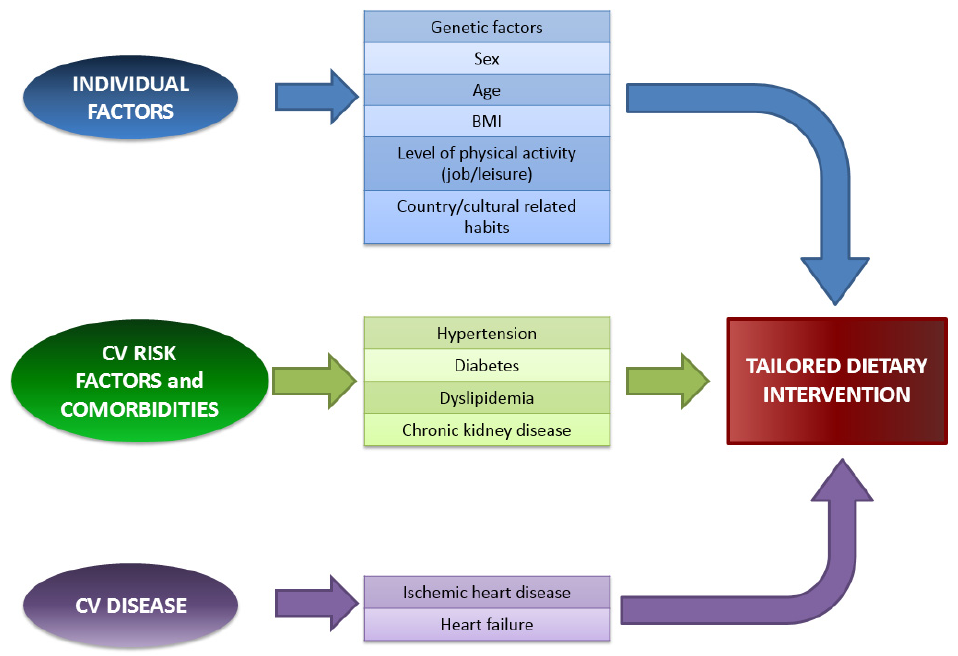
Figure 1. Factors to consider for tailoring dietary interventions in patients with CVD. BMI, Body Mass Index; CV(D), Cardiovascular (Disease).